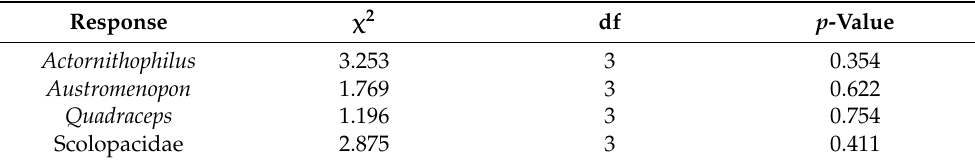
Table 5. Likelihood ratio test results for fitted model with flyway and host length compared to null model (containing only the random